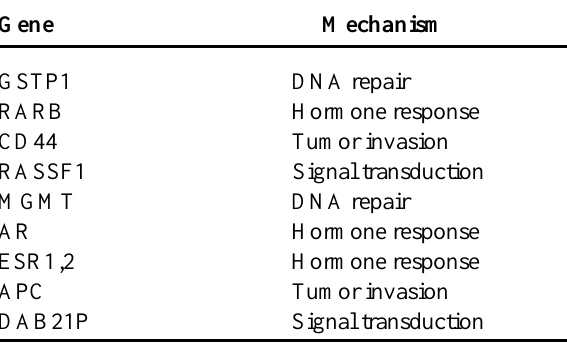
Table 1 – Hypermethylated genes in prostate